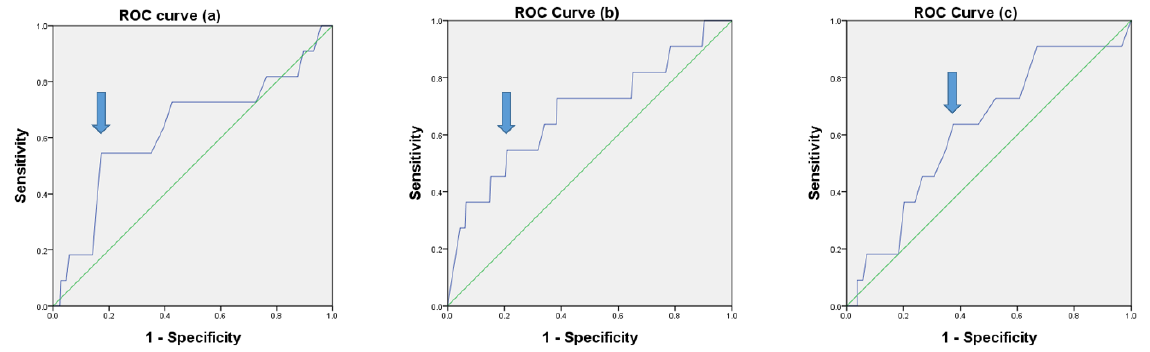
Figure 1. ROCcurvesforLNR( a ), CLNR( b ), andLLNR( c )( p= 0.141, p= 0.043, and p= 0.177, Figure 1. ROC curves for LNR ( a ), CLNR ( b ), and LLNR ( c ) ( p = 0.141, p = 0.043, and p = 0.177, respectively).